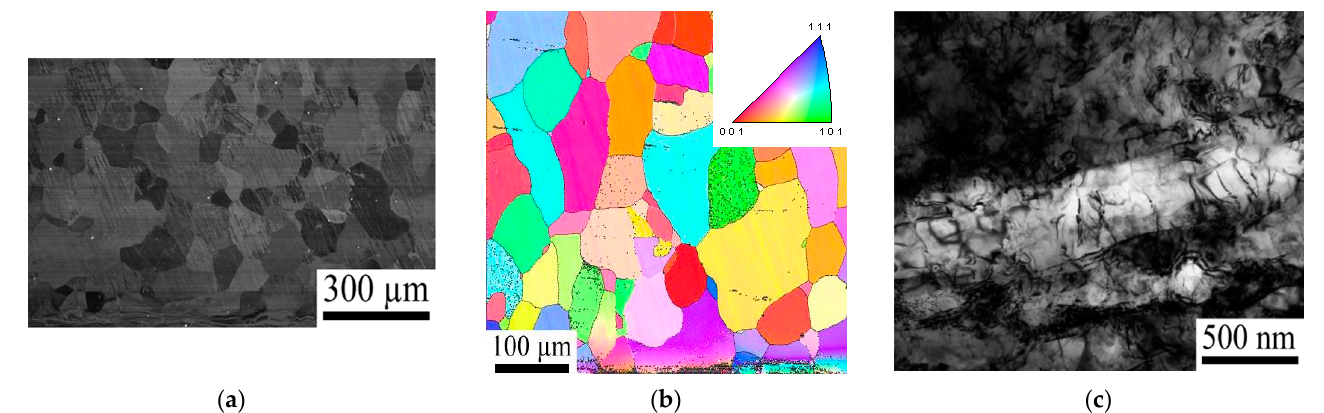
Figure 6. Microstructure of ARMCO iron after LSP: ( a ) SEM image, ( b ) EBSD IPF map and ( c ) TEM image; the bottom edge of the SEM image corresponds to the surface of the specimen.